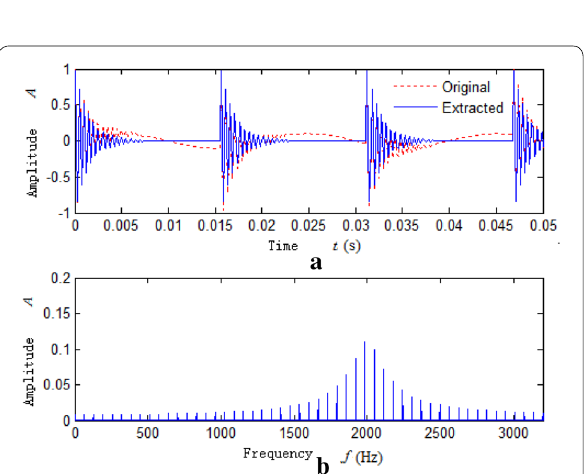
Figure 15 Extraction result of the CMF: ( a ) time waveform, ( b ) FFT